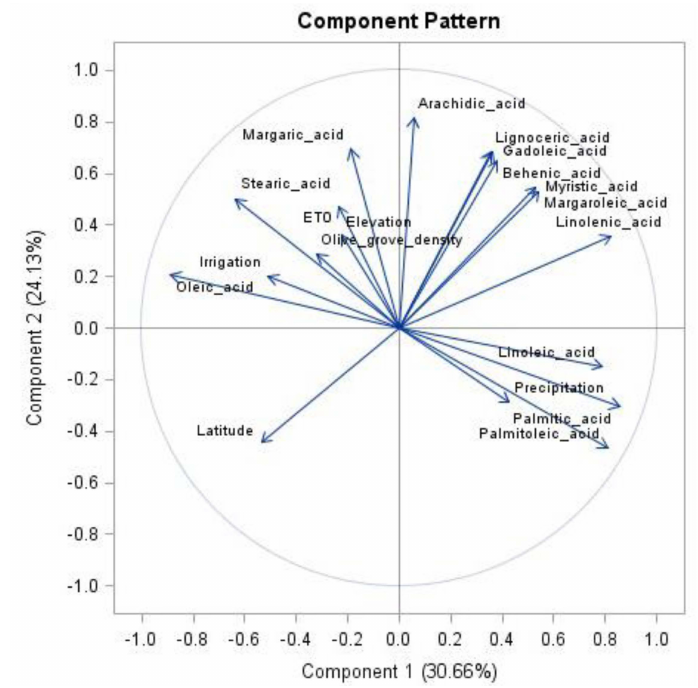
Figure 6. Principal component analysis (PCA) biplot (54.79 % of explained variance) after Varimax rotation including main meteorological and orchard characteristics and the fatty